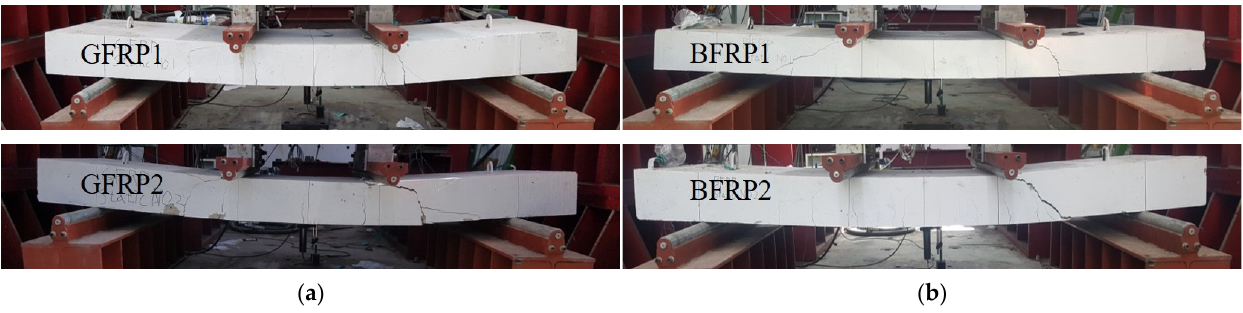
Figure 5. Failure state of FRP-reinforced concrete specimens: ( a ) GFRP specimen; ( b ) BFRP speci- men.